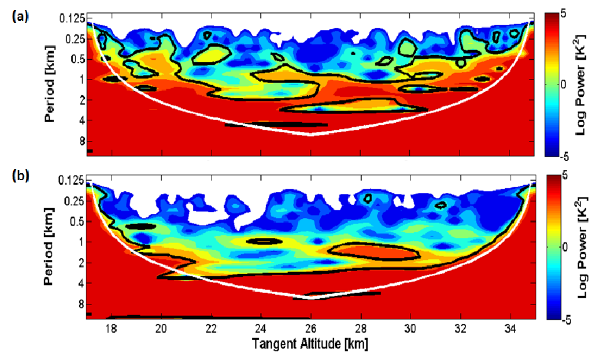
Figure 1. Wavelet power spectrum using Morlet mother wavelet for (a) GOMOS HRTP and (b) Radiosonde SHADOZ temperature profile illustrated in Figure 2. The black lines in both graphs con- tours the areas where the power is considered to exceed the 95% confidence level, whereas the white line contours the area defined by the Cone Of Influence